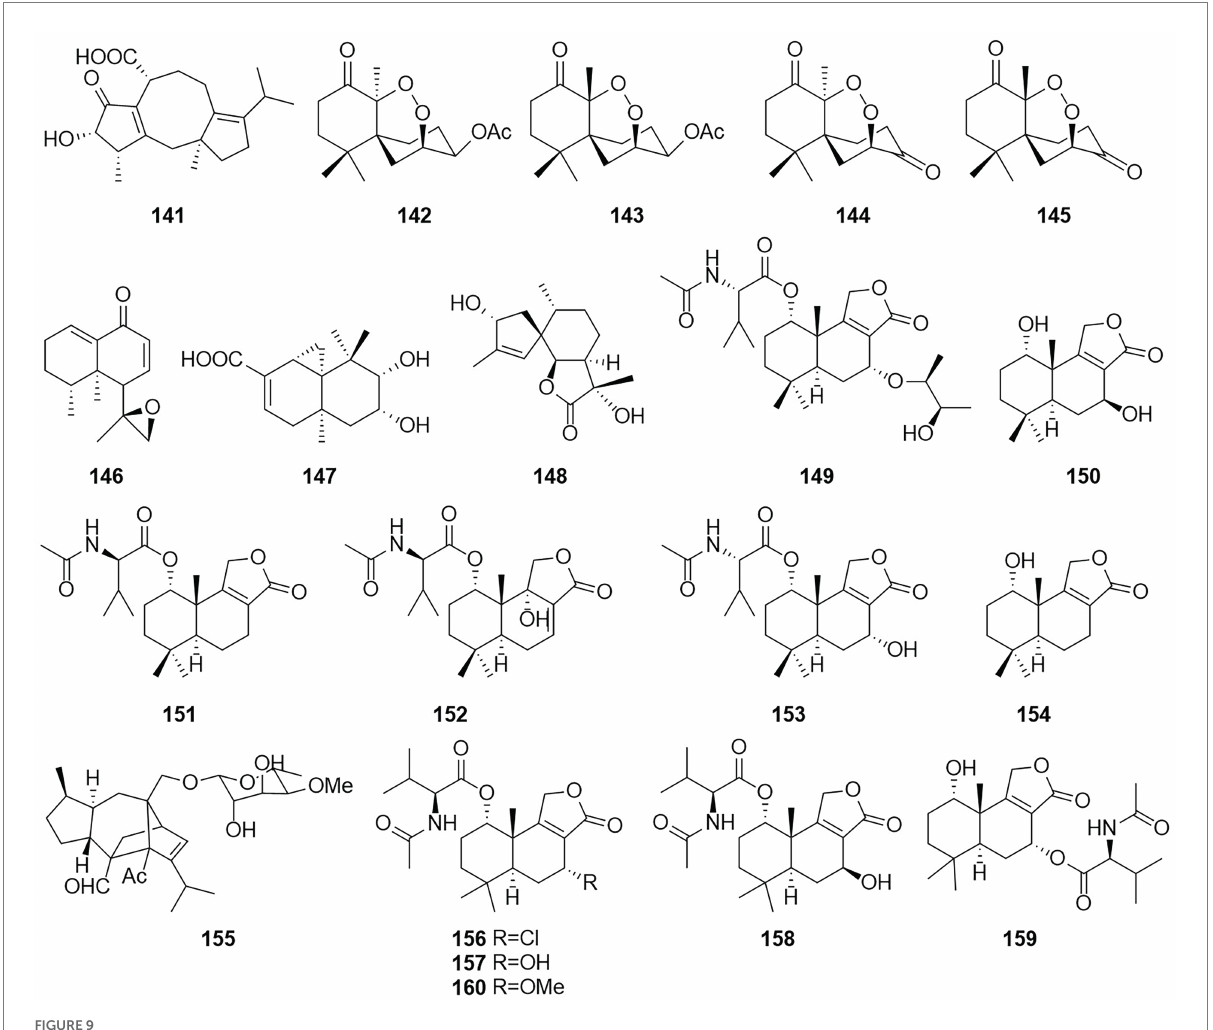
FIGURE 9 Chemical structures of compounds 141–160